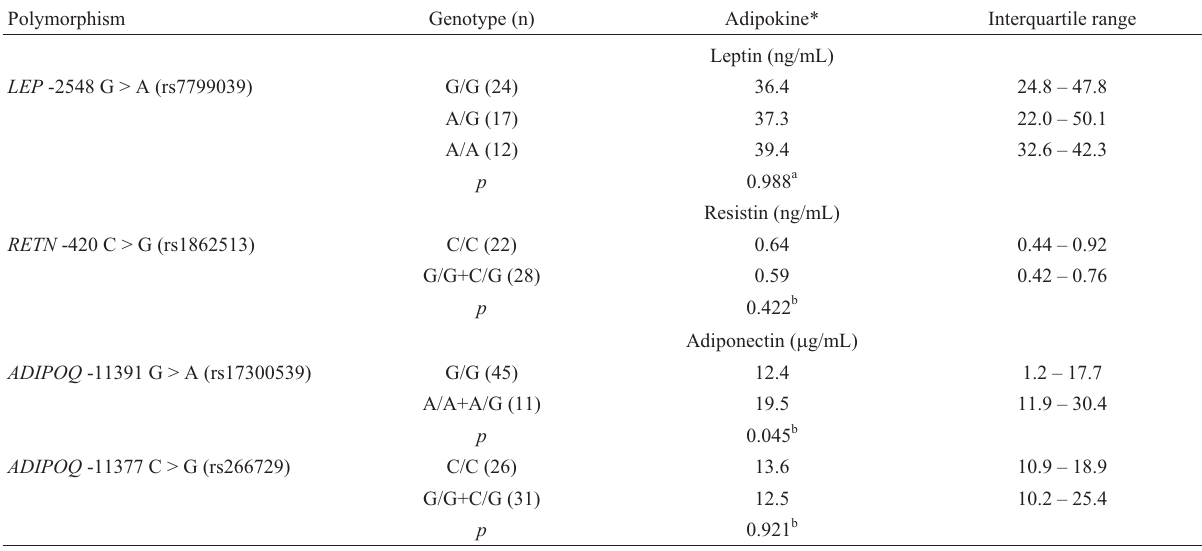
Table 2 - Comparison of adipokines (leptin, resistin and adiponectin) plasma levels among their respective encoding-gene polymorphisms genotypes be- fore surgery.